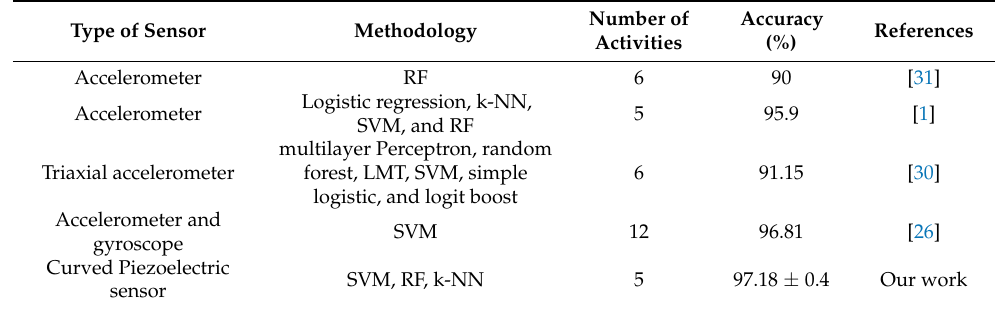
Table 3. Comparison analysis of HAR using various machine learning algorithms.